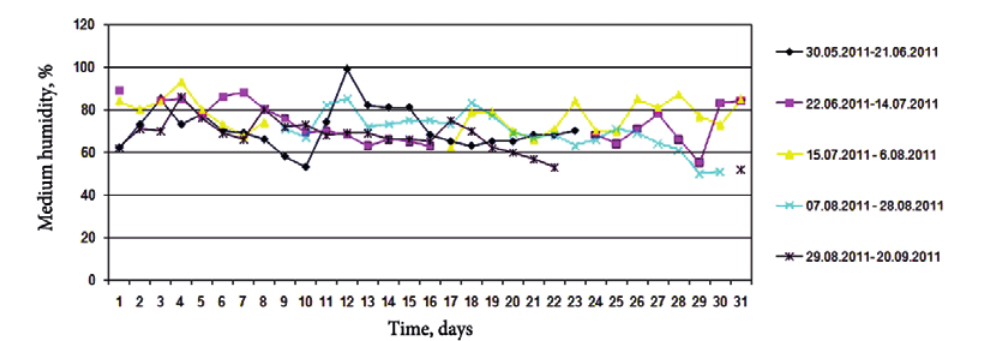
Fig. 4. Variation of medium humidity along the duration of the phenological phases